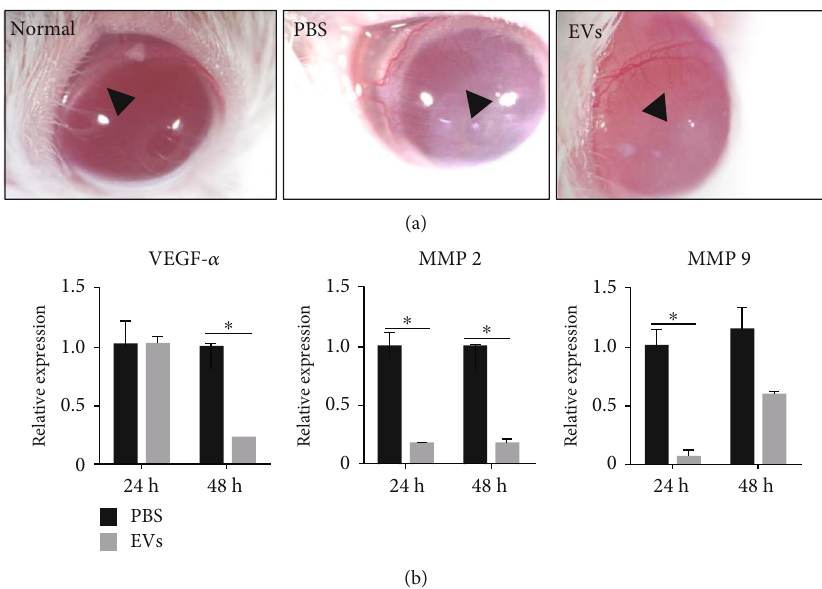
Figure 5: Inhibited cornea angiogenesis with EV treatment. (a) Injury-induced angiogenesis was signi fi cantly inhibited by EV applications (arrowhead). The arrowheads point out the margin of the corneal neovascularization. The distance of the margin of corneal neovascularization of EVs was longer than that of the control group and close to that of the normal group. In addition, in the PBS group, the opaci fi cation area was larger than that of the EVs group. The therapy improved the corneal transparency. (b) qRT-PCR revealed that angiogenesis-related mRNA levels of MMP2, MMP9, and VEGF-a were signi fi cantly decreased after treatment. All data were shown as means ± SEM in triplicate assays. ∗ P < 0 : 05 versus